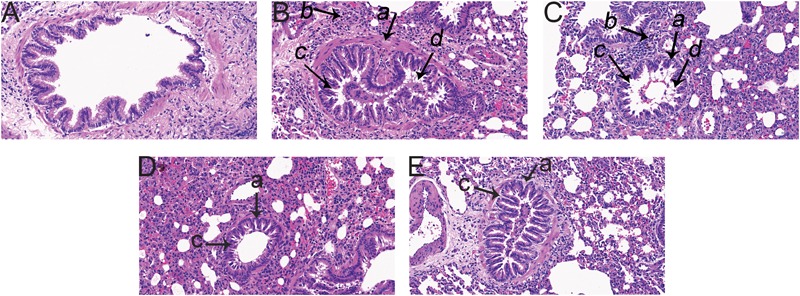
Pathological changes in lung tissue observed by hematoxylin and eosin (HE) staining (Light microscopy, ×200). 4.86 g/kg Gan Jiang and 21.6 g/kg of Linggan Wuwei Jiangxin (LGWWJX) decoction significantly reduced inflammation and pathological changes compared with the model group. LGWWJX decoction alleviated airway wall thickening and inflammatory cell infiltration to a greater extent than GJ. (A) control; (B) model; (C) Gan Jiang (GJ, 4.86 g/kg); (D) LGWWJX decoction (LGWWJX, 21.6 g/kg); (E) postive control (PC, Guilong Kechuanning, 2.43 g/kg). (a) airway wall; (b) inflammatory cell infiltration; (c) airway luminal narrowing; (d) mucous plug.